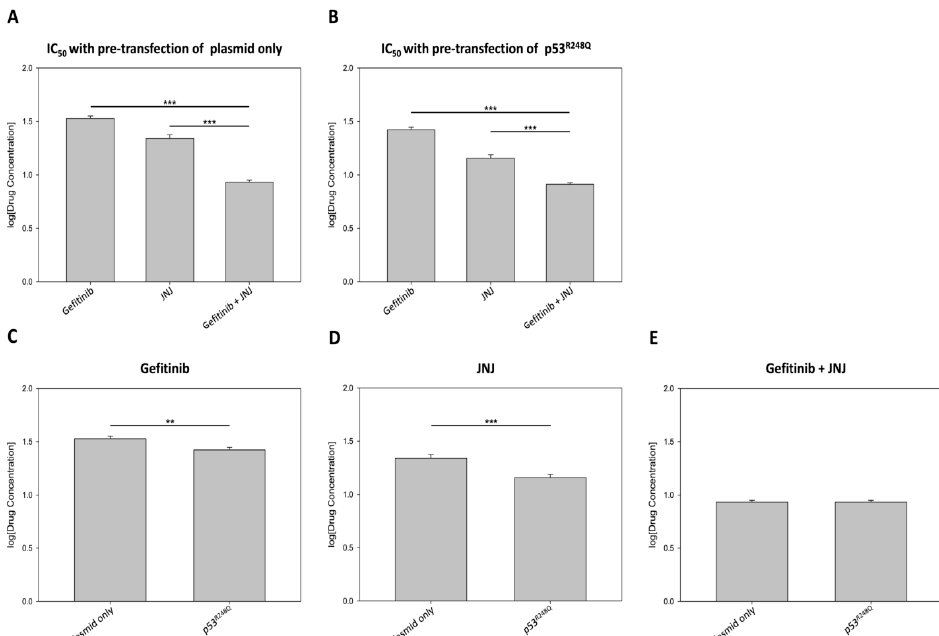
Figure 4. Overexpression of p53 R248Q in OVCAR3 cells increased sensitivity to gefitinib or JNJ. In this experiment, OVCAR3 cells were pre-transfected with either empty plasmid (1 μ g/mL) or p53 R248Q (1 μ g/mL) for 18 h and then exposed to the inhibitors alone or in combination for another 48 h. The doses of gefitinib and JNJ ranged from 5 to 40 μ M and 1 to 36 μ M, respectively. The concentrations of gefitinib and JNJ in combination were prepared in a one-to-one ratio, with doses ranging from 0.5 to 12 µ M. The effects on cell proliferation were assessed by CCK-8 assay; the half maximal inhibitory concentration (IC 50 ) values (in log10) were calculated by GraphPad Prism 6. ( A ) In the absence or ( B ) in the presence of p53 R248Q overexpression, the combined treatment of gefitinib and JNJ significantly reduced the IC 50 values for each agent in OVCAR3 cells (*** p < 0.001 vs. gefitinib and JNJ). ( C , D ) The sensitivities to gefitinib or JNJ alone increased significantly in p53 R248Q -overexpressing cells (** p < 0.01; *** p < 0.001). ( E ) No significant difference was found when the combination treatment of gefitinib and JNJ was applied to the plasmid-only transfected cells and the p53 R248Q -overexpressing